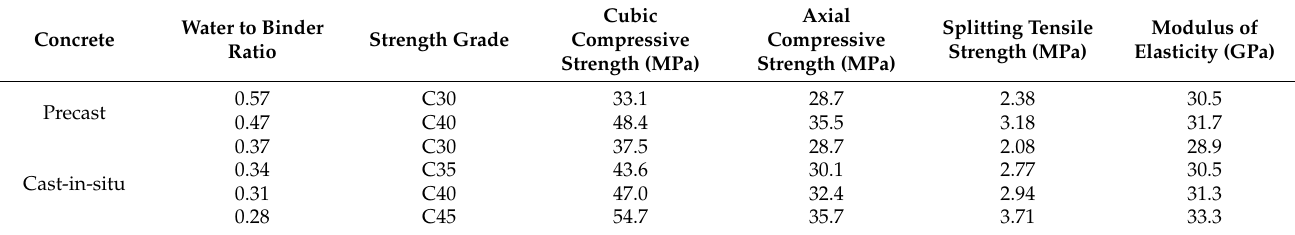
Table 7. Mechanical properties of precast concrete and cast-in-situ